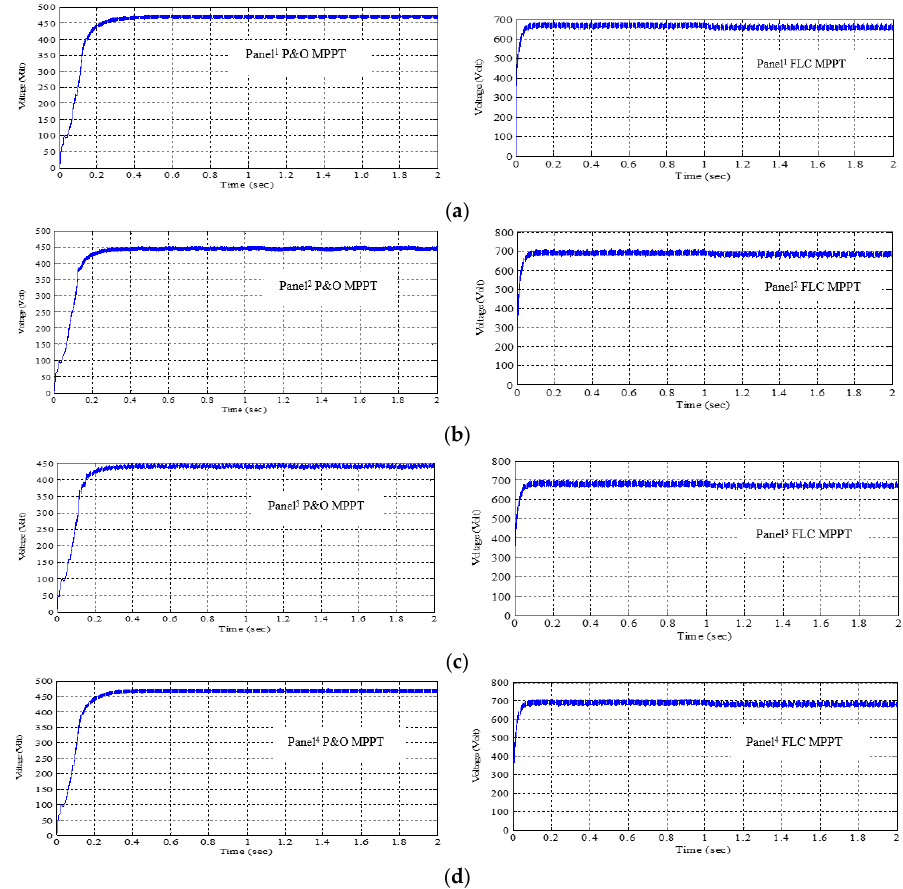
Figure 12. Comparison of output voltage obtained using P&O MPPT ( left ) and FLC MPPT ( right ) methods for PV ( a ) panel 1 , ( b ) panel 2 , ( c ) panel 3 and ( d ) panel 4 respectively with boost converter.